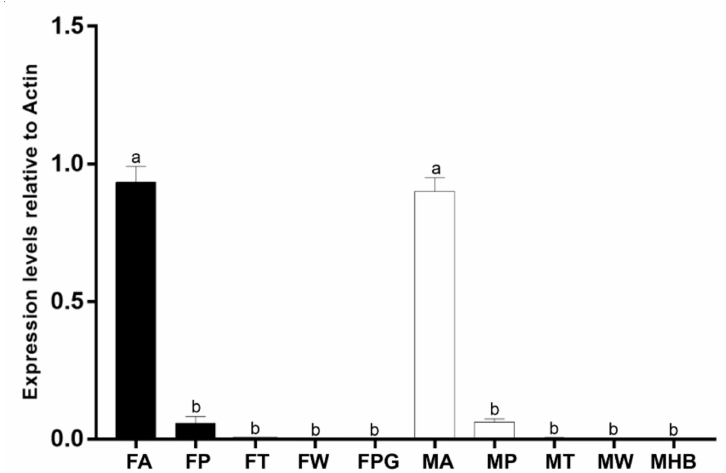
Figure 3. Expression patterns of PsauGOBP1 in different tissues of P . saucia . RT-qPCR analyses were conducted for PsauGOBP1 in the following tissues: female antennae (FA); female proboscises (-FP); female tarsi (FT); female wings (FW); female pheromone glands (FPG); male antennae (MA); male proboscises (MP); male tarsi (MT); male wings (MW); male hair brushes (MHB). Values are means + SE (n = 3). Means with different letters are significantly different ( p < 0.05) according to a one-way ANOVA followed by a Tukey multiple comparison test.